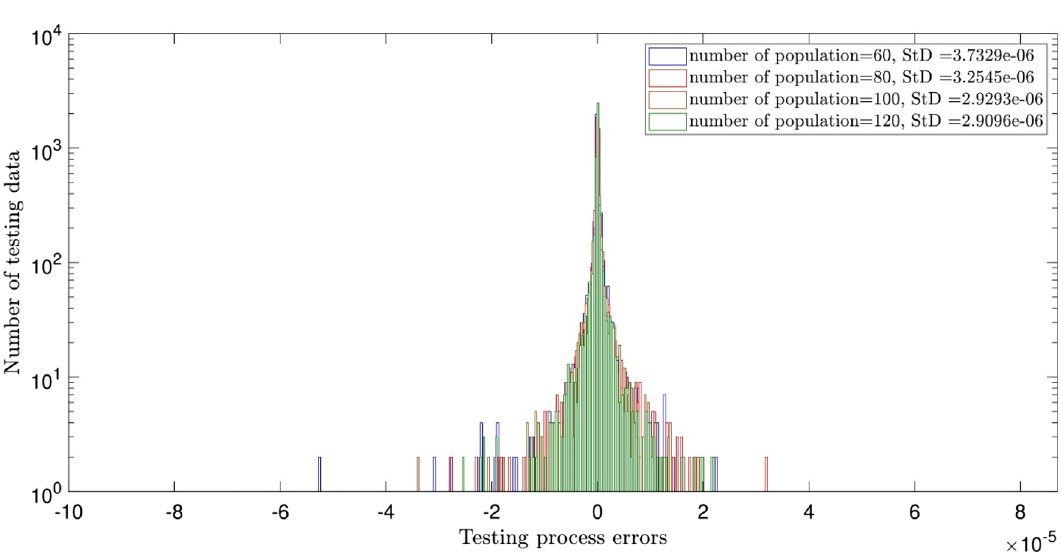
Figure 5. Standard deviation errors for different DEFIS learning processes considering different population with three